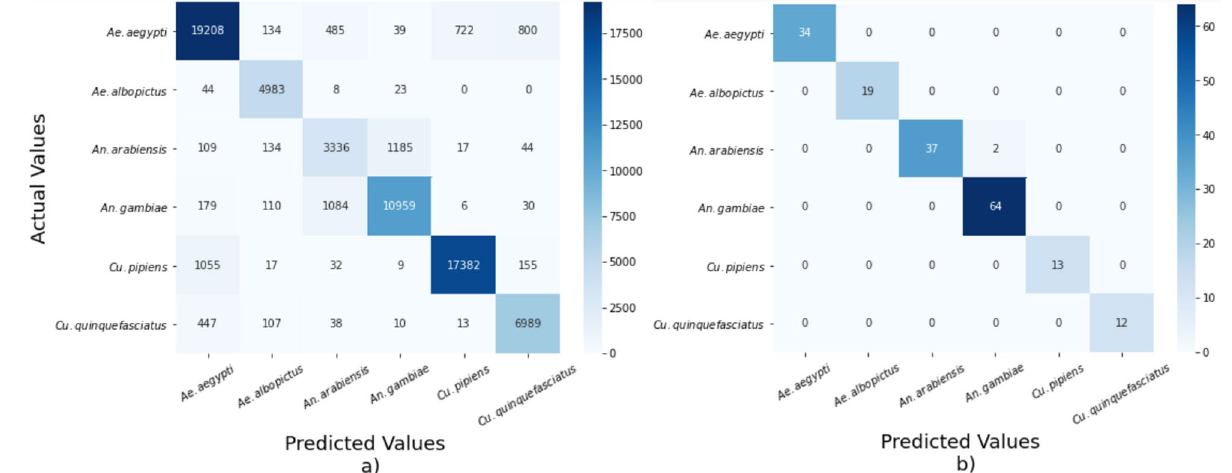
Figure 2. Confusion matrix of WbNet on ( a ) WINGBEATS, ( b ) ABUZZ.